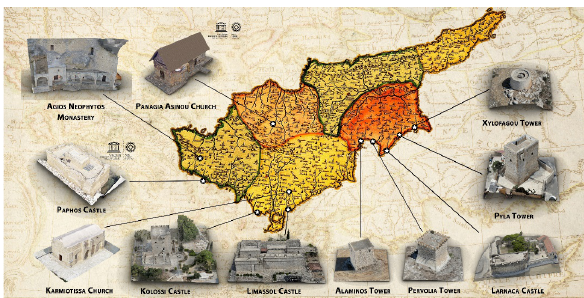
Figure 2. The UNESCO Chair on Digital Cultural Heritage at